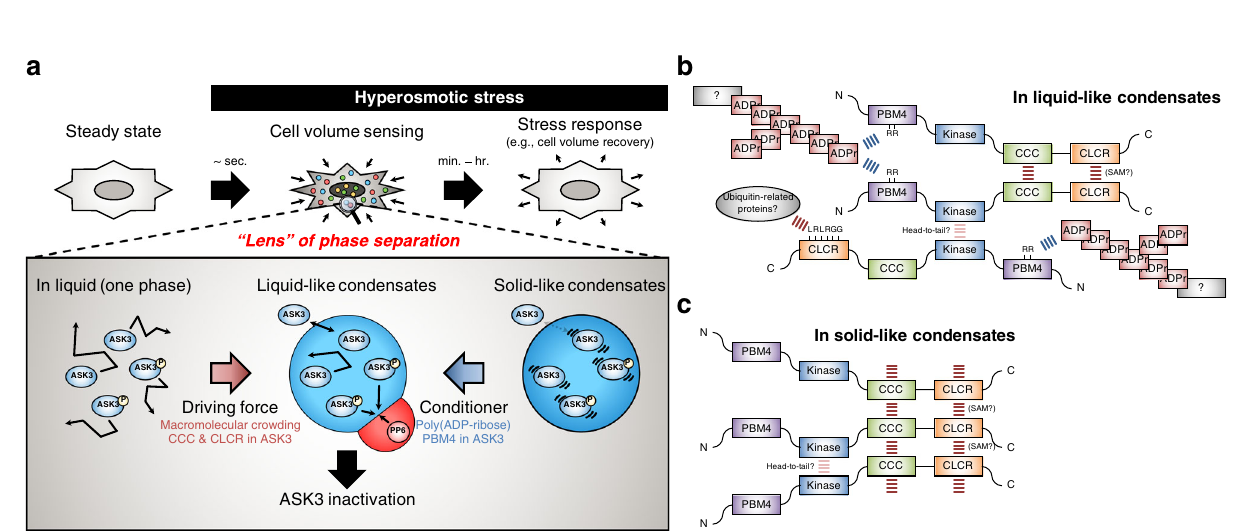
Fig. 6 Interaction between ASK3 and PAR is required for the liquidity of ASK3 condensates and ASK3 inactivation under hyperosmotic stress. a Candidate PAR-binding motif (PBM) in ASK3. Schematic representation of ASK3 is the same as that in Fig. 3a. The numbers indicate the amino acid (a.a.) positions in wild-type (WT). b Subcellular localization of ASK3 PBM candidate mutants in HEK293A cells. Hyperosmotic stress: 500 mOsm, 10 min. White bar: 20 μ m, red bar: 2.5 μ m. A representative image set from three independent experiments is presented. c Inactivation of ASK3 PBM candidate mutants under hyperosmotic stress in HEK293A cells. p-ASK endo : phosphorylation bands of endogenously expressed ASK. d Ability of the ASK3 PBM4 mutant to interact with PAR under hyperosmotic stress in HEK293A cells. FK866 ( − ): dimethyl sulfoxide (DMSO), solvent for FK866; ( + ): 10 nM FK866; 12 h pretreatment. c , d Hyperosmolality ( − ): 300 mOsm; ( + ): 500 mOsm; 10 min. IB: immunoblotting, IP: immunoprecipitation. A representative image set from six ( c ) or four ( d ) independent experiments is presented (quanti fi cation: Supplementary Fig. 5j, k). e , f FRAP assay for condensates of the ASK3 PBM4 mutant in HEK293A cells. Prior to the assay, cells transfected with each ASK3-tdTomato were exposed to hyperosmotic stress (600 mOsm, 30 min). Data ( e ): mean ± SEM; data ( f ): center line = median; box limits = [ Q 1 , Q 3 ]; whiskers = [max(minimum value, Q 1 − 1.5 × IQR), min(maximum value, Q 3 + 1.5 × IQR)], where Q 1 , Q 3 and IQR are the fi rst quartile, the third quartile and the interquartile range, respectively; n = 9 (CT), 11 (WT), 12 (PBM4) cells pooled from four independent experiments. *** P < 0.001 according to two-sided Welch ’ s t -tests wi t h the Bonferroni correction. g , h Effects of PAR on the solid-like condensates of the ASK3 PBM4 mutant in vitro. Control: 150 mM NaCl, 20 mM Tris (pH 7.5), 1 mM DTT, 20% PEG, 15-min incubation on ice. PAR: 2.5 μ M, white bar: 5 μ m. Data: mean ± SEM, n = 4 independent experiments. * P < 0.05, n.s. (not signi fi cant) according to two-sided Student ’ s t -test with the Bonferroni correction.